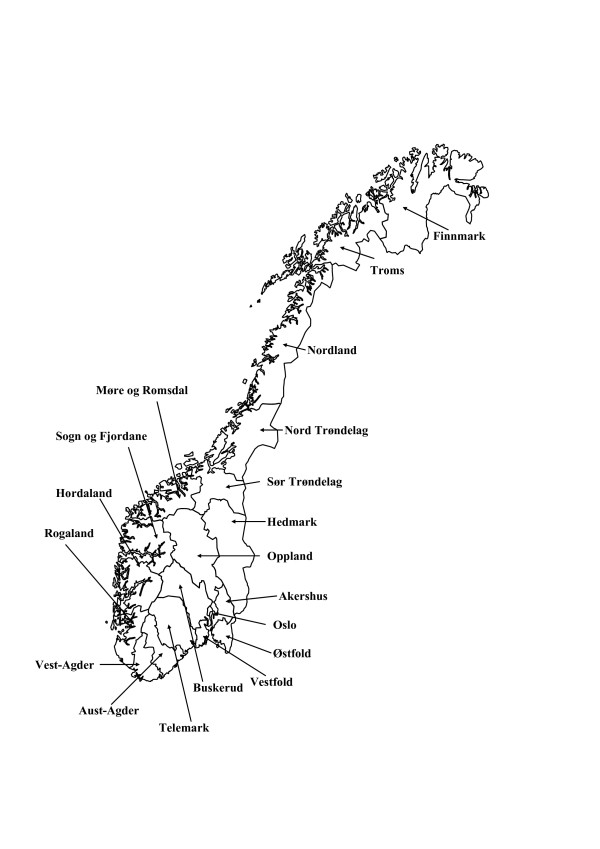
A map of Norway showing the different counties.